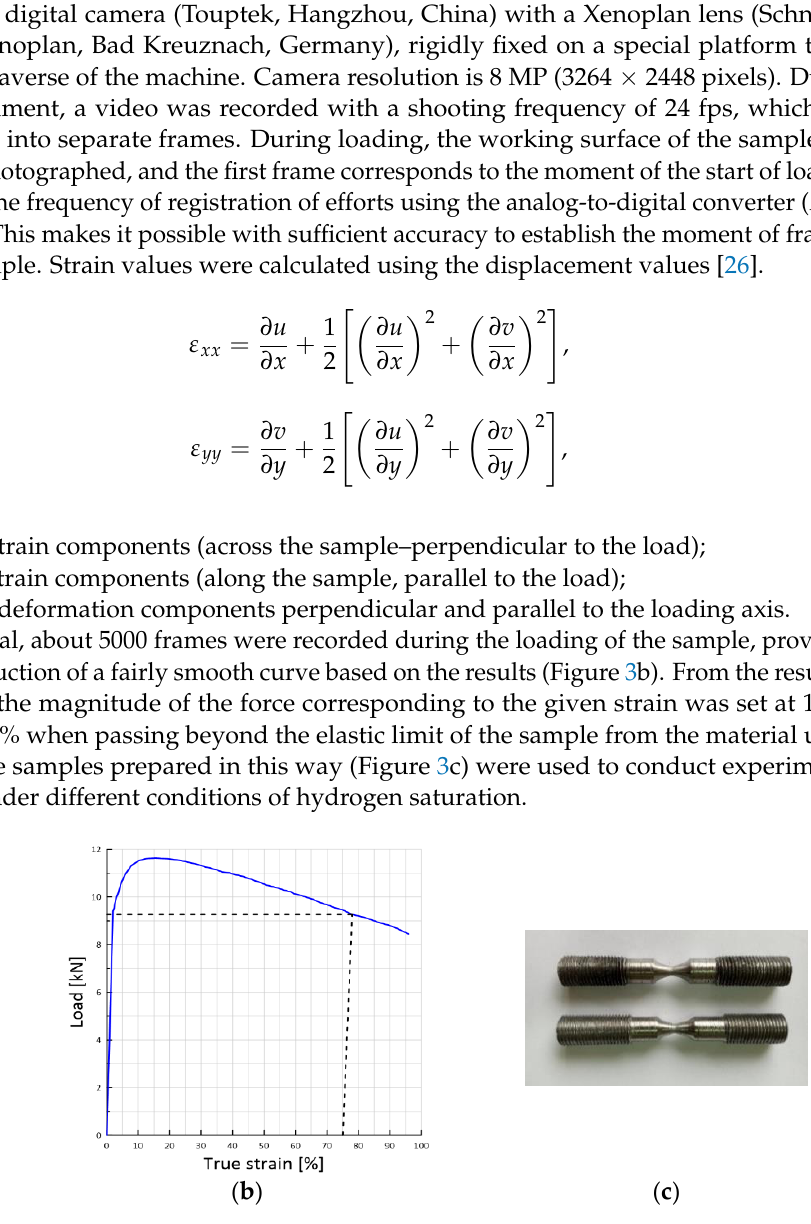
(Figure 3a) were obtained by an optical system based on a Toupcam UCMOS 10000KPA